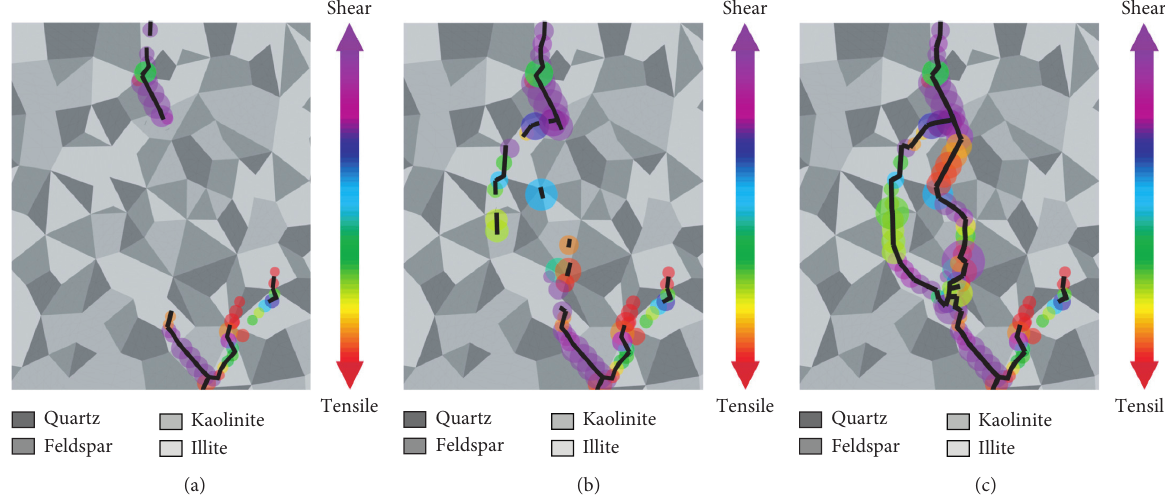
Figure 12: The formation process and AE location of fragment in loading method IV. Red dots are the AE location of tensile fractures, purple dots are the AE location of shear fractures, and the colors between the two are the AE location of tensile-shear fractures. The size of the dot represents the level of AE